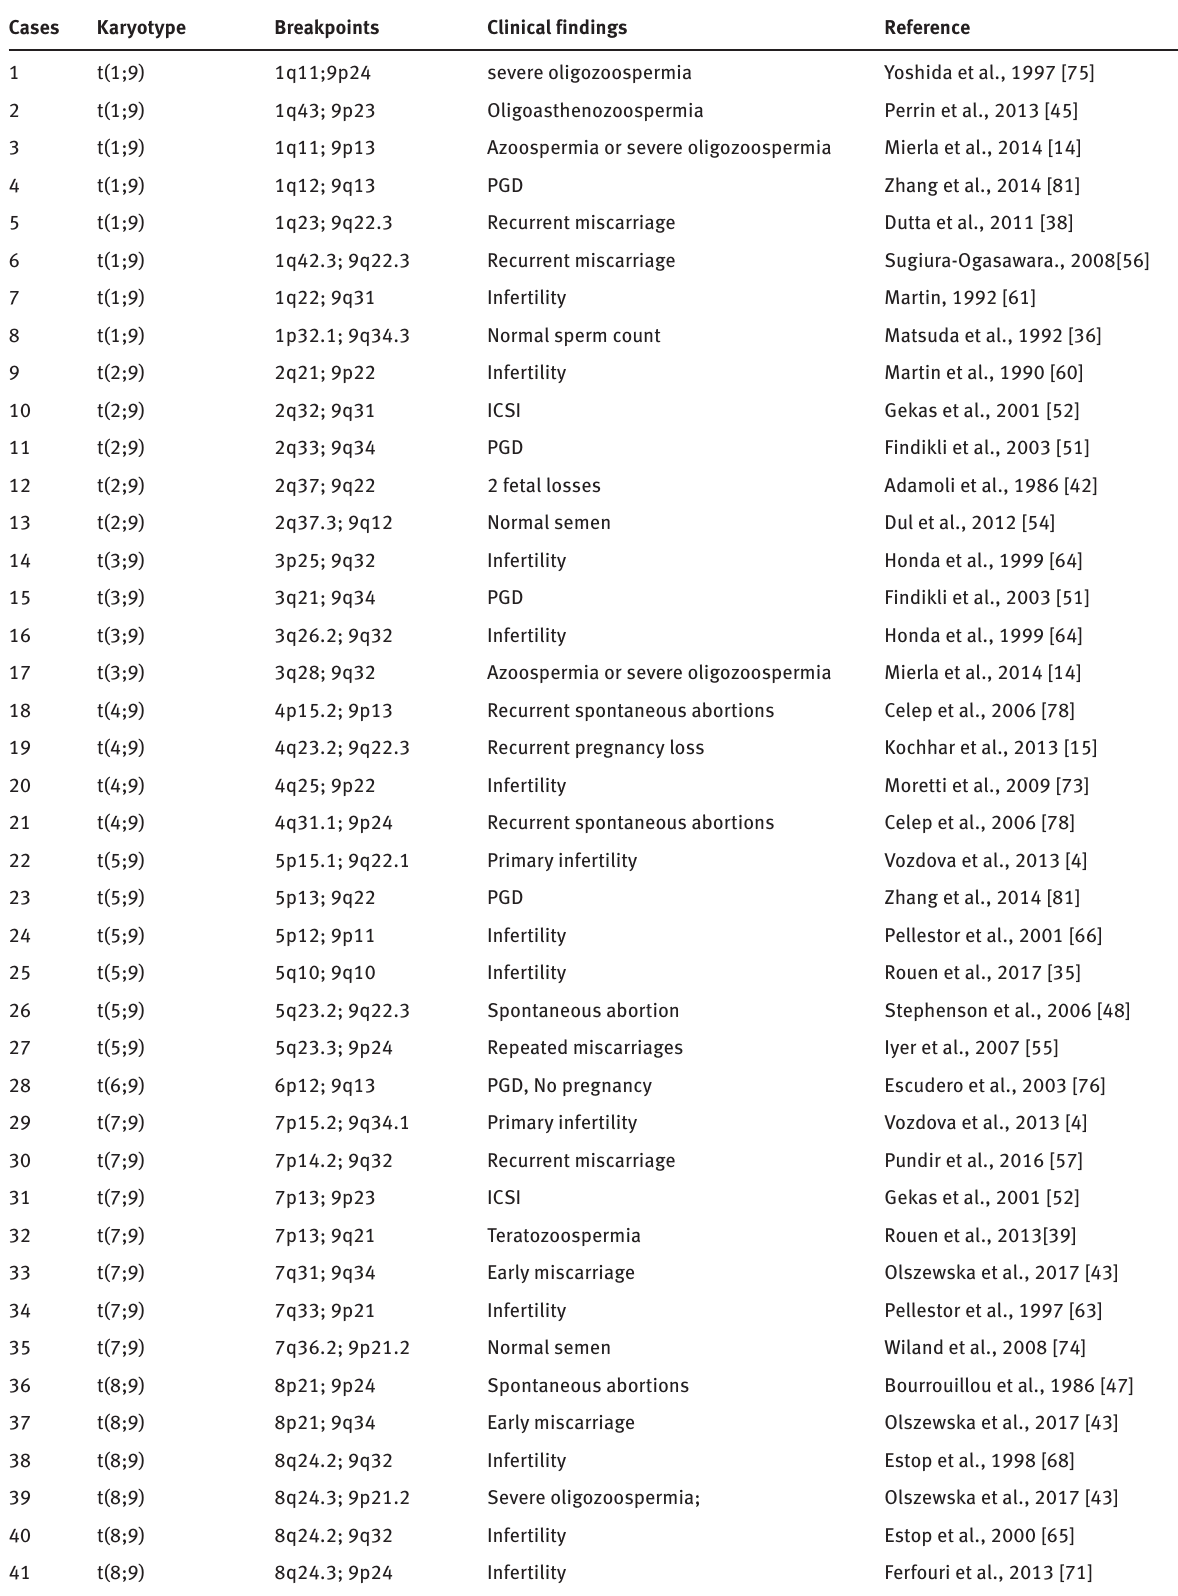
Table 2: Breakpoints in chromosome 9 translocation carriers and clinical features reported in previous literature